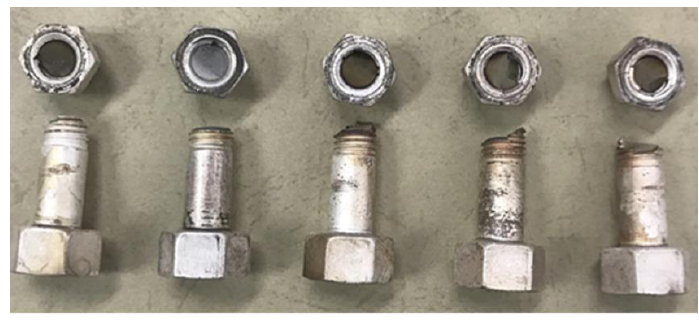
Figure 6. Failure specimens after the fatigue test.